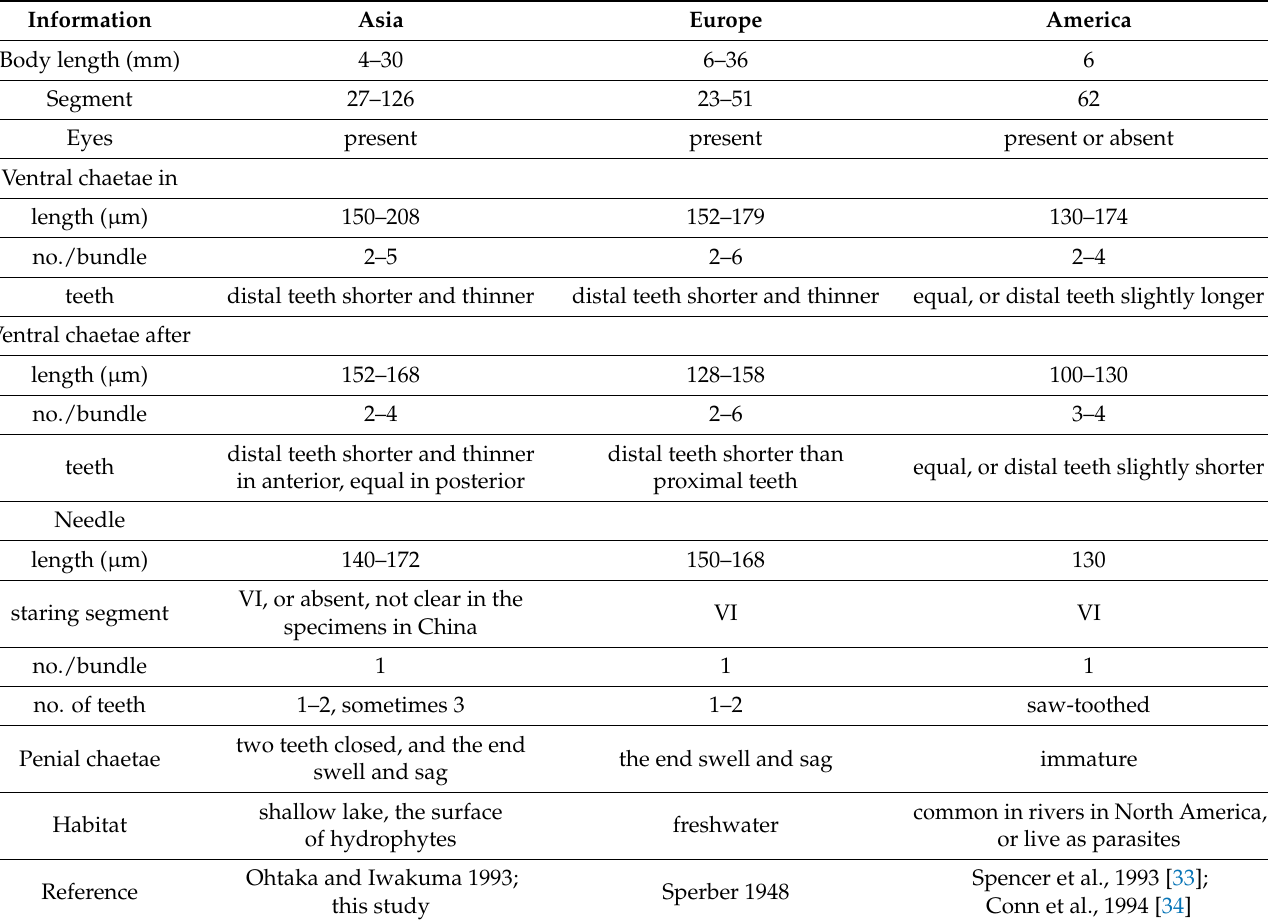
Table 5. The differences in morphology of Ophidonais serpentina from different